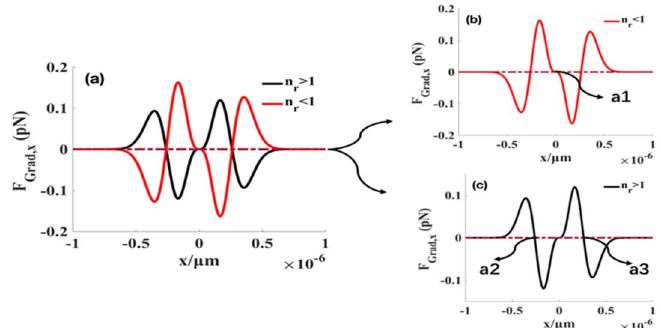
Figure 3. Transverse gradient forces produced by focused SMGBs on high-index ( n p = 1.592 ) and low-index ( n p = 1 ) particles along x direction. The black solid curve shows particles with n p = 1.592 , and the red solid curve shows particles with n p = 1 . The reddish-brown dotted line is the coordinate axes. ( a ) Transverse gradient force at the focus plane. The exploded diagram of ( a ) is ( b ) and ( c ). We select a sphere with a radius a = 20nm, and n r = n p / n m represents the relative refractive index. n m = 1.332 is the refractive index of the surrounding field, and the high and low refractive indices are the homogeneous Rayleigh nanospheres. Other parameters are (cid:31) = 1.064 µ m , w 0 = 5 mm , f = 5mm , P = 4 w , and the sine-modulation coefficient g = 1 .